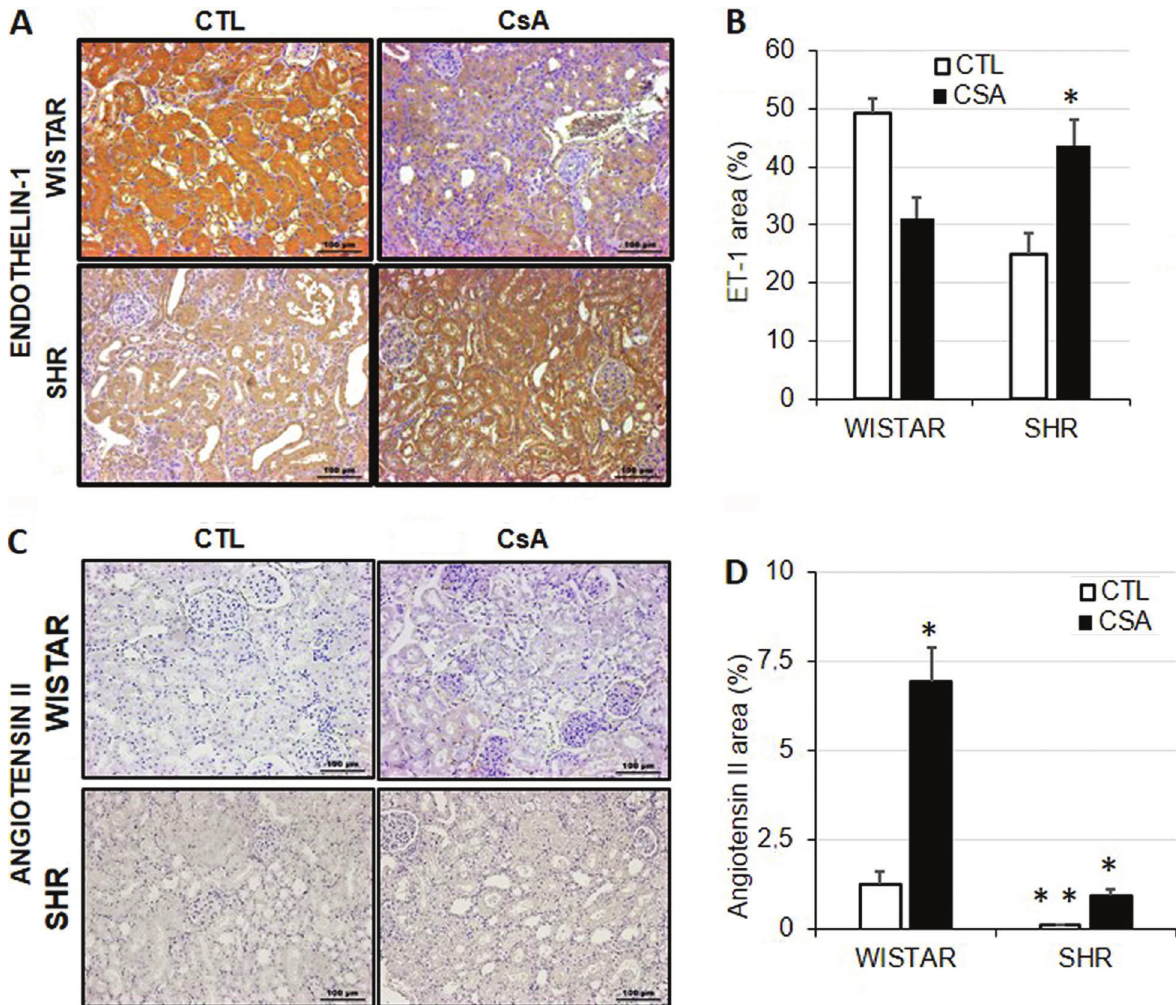
Figure 4. A , Light microscopy of kidney sections immunostained for endothelin-1 (ET-1, 200 (cid:4) ) and ( C ) angiotensin II (200 (cid:4) ) in control rats (CTL) and rats receiving cyclosporine-A (CsA). B , Quantitative analyses of kidney sections stained for ET-1 and ( D ) angiotensin II. Data are reported as means ± SE. The signi fi cance level for a null hypothesis was set at 5% (P o 0.05). *P o 0.05, compared to the CTL group, and **P o 0.05, compared to the respective normotensive group (ANOVA followed by the Tukey test or Student ’ s t -test). SHR: genetically hypertensive